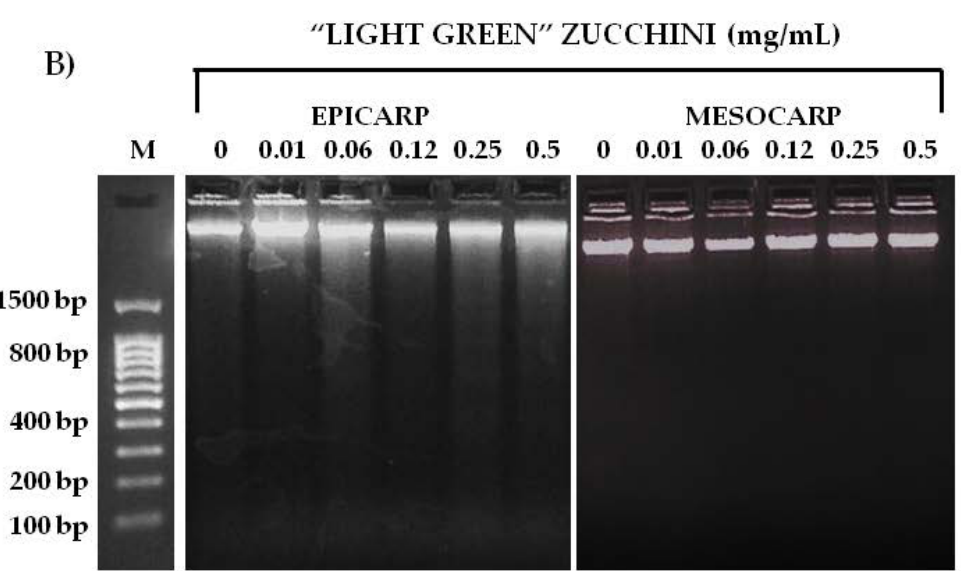
Figure 5. Nucleosomal DNA fragmentation assay: ( A ) “Yellow” zucchini; and ( B ) “Light Green zucchini. HL-60 cells were exposed to various concentrations of zucchini epicarp and mesocarp for 5 h. DNA was extracted from cells and was subject to 2% agarose gel electrophoresis at 50 V for 90 min. M: DNA size marker.